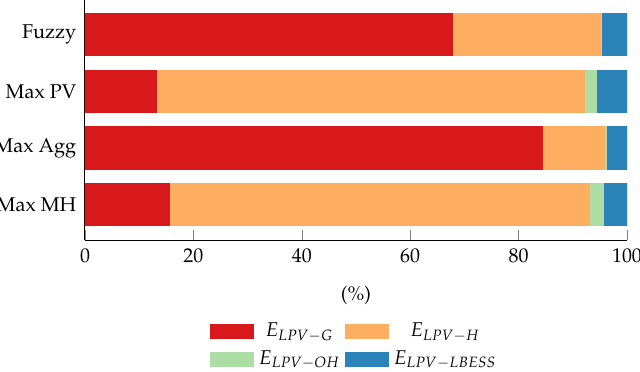
Figure 9. Distribution of the energy produced by local PVs.